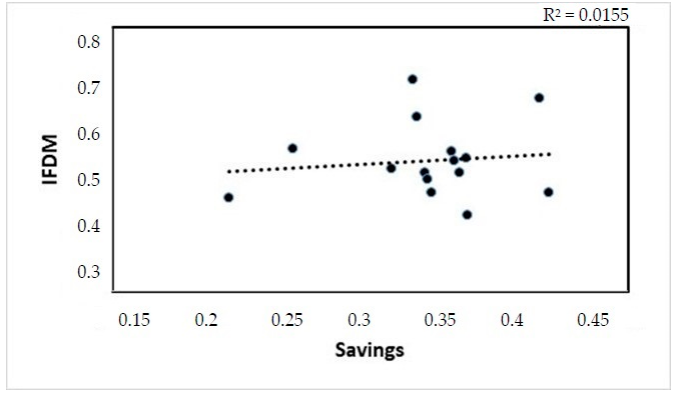
Figure 7. Scatterplot Savings x IFDM—Spatial dimension.